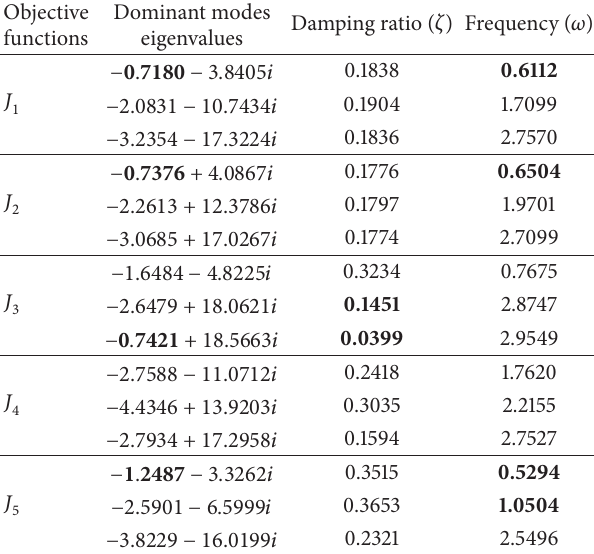
Table 3: Comparative improvement in dominant modes for differ- ent objective functions.